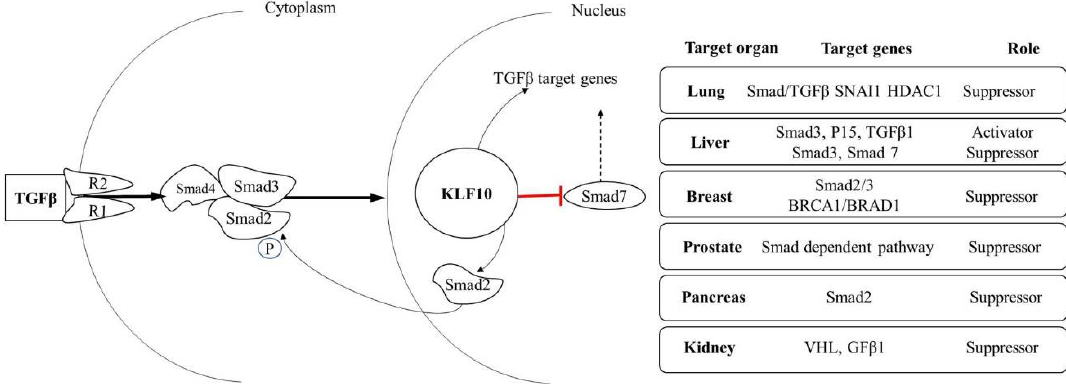
Figure 2. TGF-β signaling and its target disease mediated by KLF10 gene. In response to TGFβ ligand binding, KLF10 gene expression is induced in a Smad dependent manner and play a role as a tumor suppressor in many cancers. TGFβ signaling occurs through TGFβ receptors (TβRI and TβRII). Binding of TGFβ ligand to TβRII facilitates phosphorylation of TβRI, which in turn phosphorylates the SMAD2 and SMAD3 proteins. After phosphorylationSmad2/Smad3 form complex with Smad4, and translocate to the nucleus to induce expression of KLF10. Subsequently, KLF10 bind to the promoters of Smad2, Smad7, and TGF-beta1, whereas the expression of the inhibitory Smad7 is blocked to disrupt the negative feedback loop. Importantly, KLF10 serves as a positive feedback loop for regulating TGFβ signaling by inducing the expression of SMAD2 and inhibiting the expression of the inhibitory SMAD7 gene in many cancers.